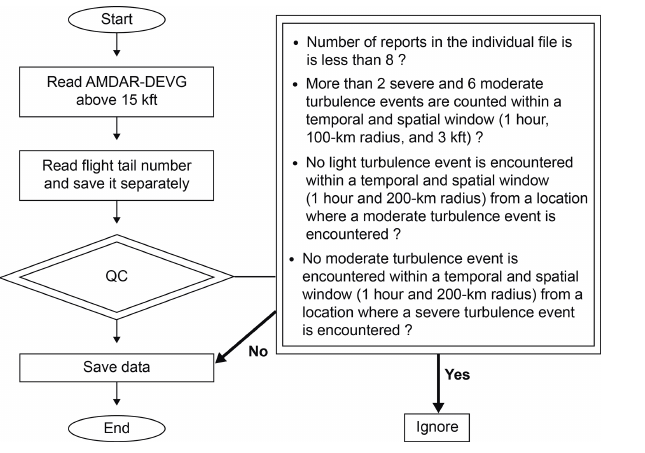
Figure 5. The flowchart of quality control